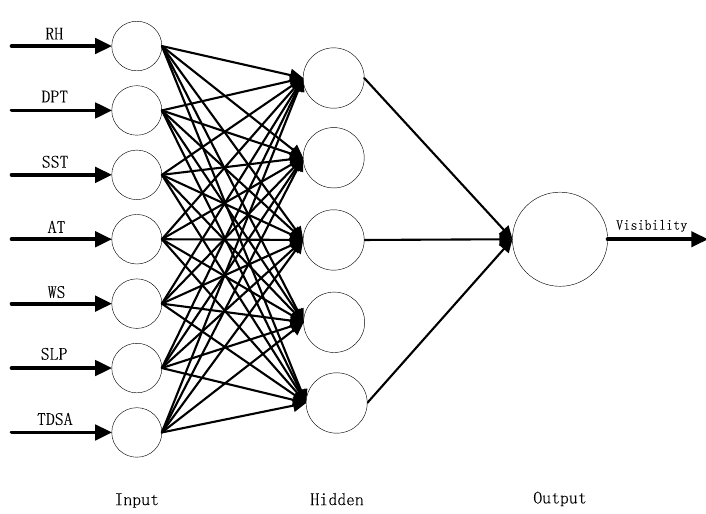
Figure 3. Artificial neural network model for inferring visibility.